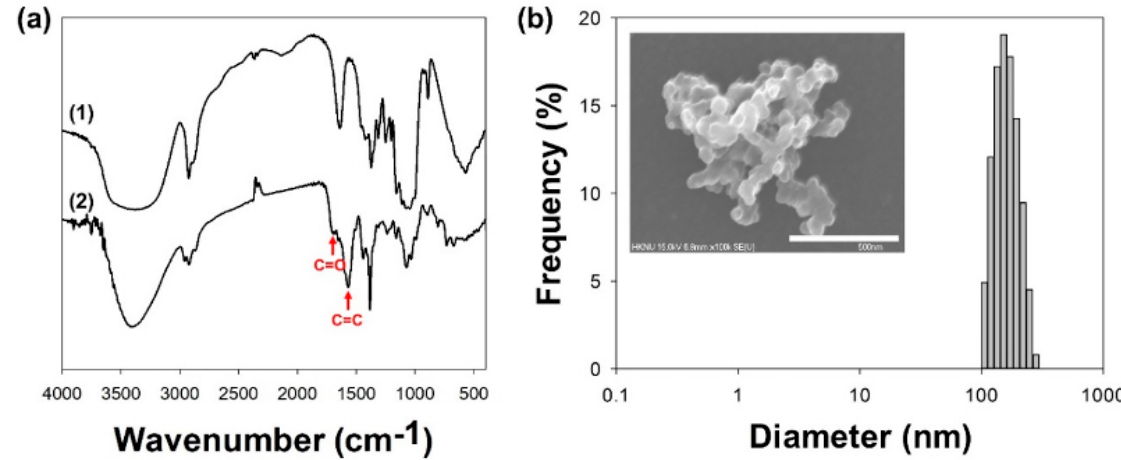
Figure 2. Characterizations of Glu/Ce6 nanocomplexes. ( a ) FTIR spectra of (1) Glu and (2) Glu/Ce6. ( b ) Particle size distribution of Glu/Ce6. Inset SEM image: the morphology of Glu/Ce6. Scale bar: 500 nm.